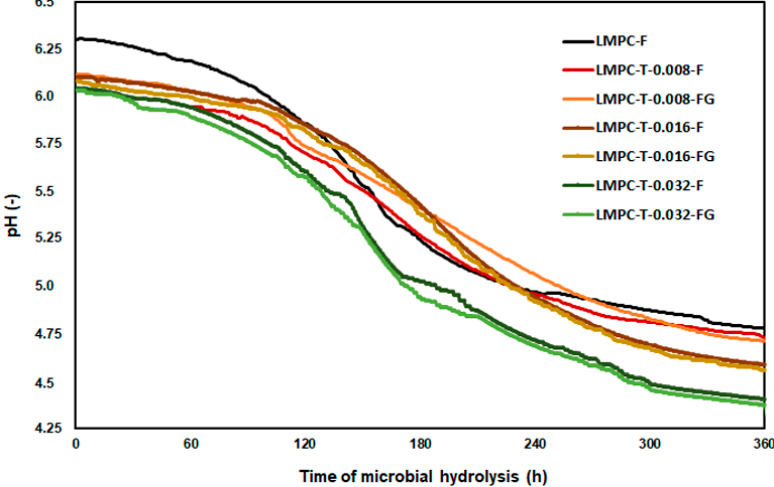
Figure 6. Changes in pH in LMPC-F, LMPC-T-F and LMPC-T-F G with time. LMPC: liquid milk protein concentrate, T: trypsin, F: fermentation with lactic acid bacteria in the absence of glucose, F G : fermentation with lactic acid bacteria in the presence of glucose.